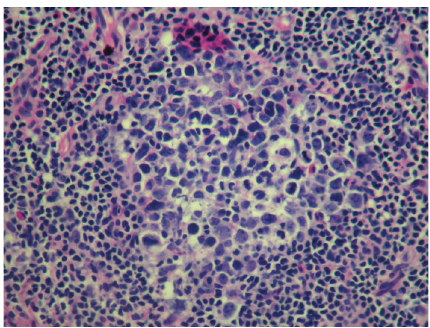
Figure 8: Histology.